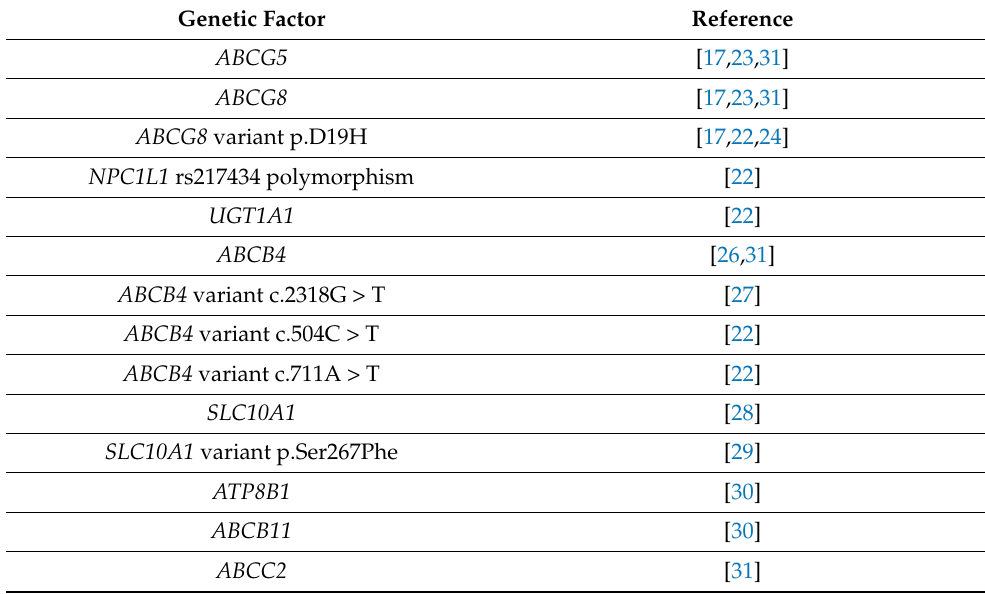
Table 1. The genetic factors analyzed in the development of cholesterol gallstone disease were reported in children on the basis of the above-mentioned